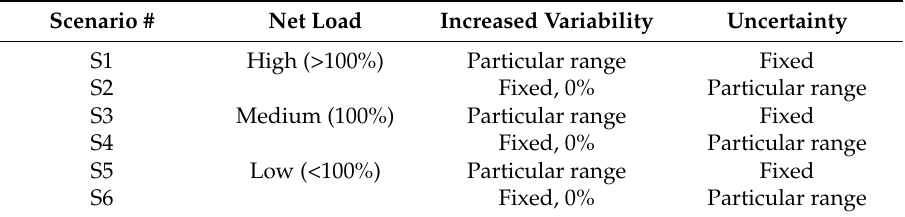
Table 1. Scenarios for three parameters at the selected time interval.